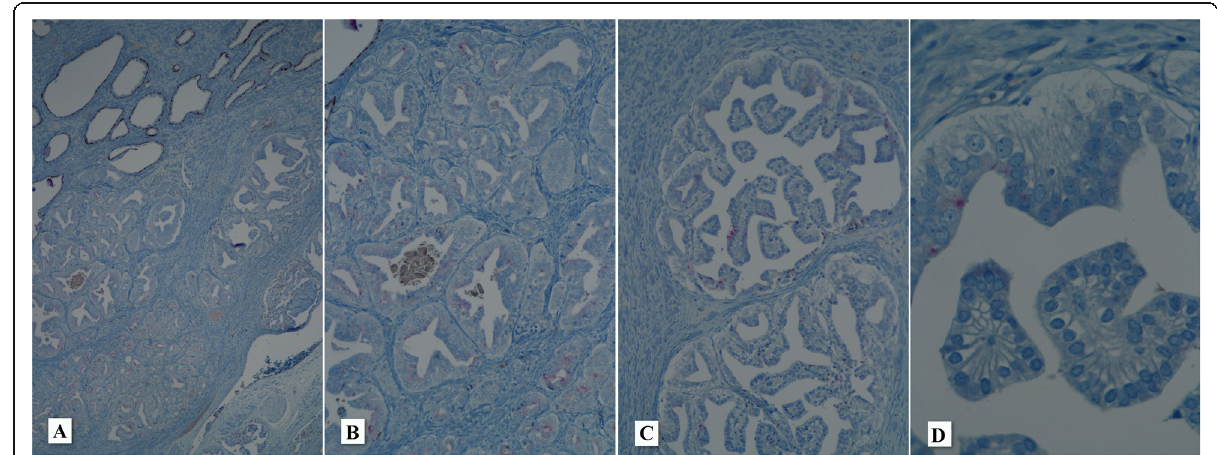
Fig. 5 Invasive prostatic adenocarcinoma with pseudohyperplastic morphology and inverse polarity showing absence of basal cells and weak cytoplasmic/luminal expression of alpha-methylacyl-CoA racemase. Immunohistochemical antibody cocktail staining – P63 and high molecular weight cytokeratins (peroxidase - brown) and alpha-methylacyl-CoA racemase (phosphatase - red): A (40x), B and C (100x) and D